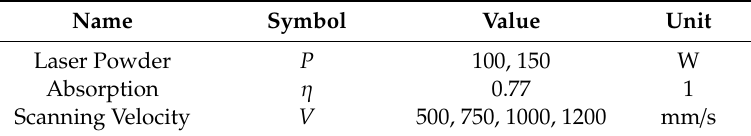
Table 2. Process parameters of PBMAM of